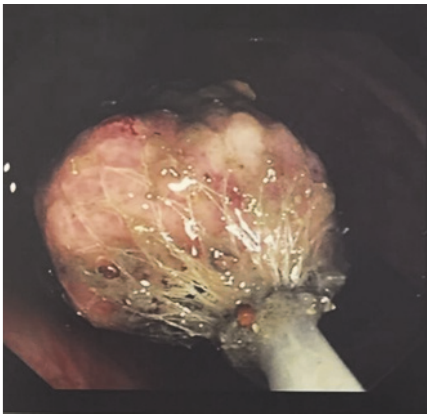
Figure 2: Polyp retrieval.